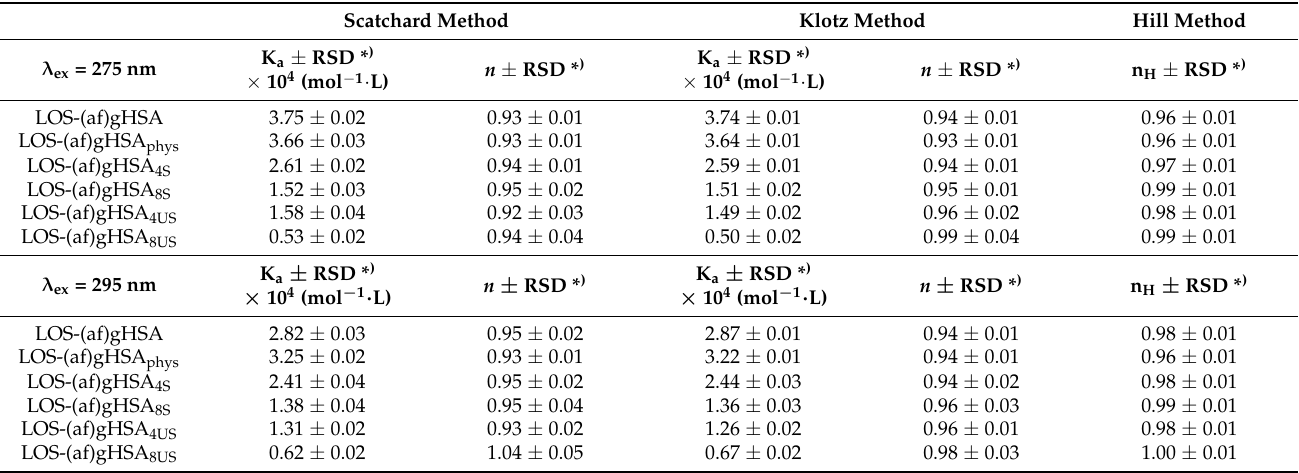
Table 3. Association constants K a (mol − 1 · L), mean number of LOS moles bound with one mole of (af)gHSA, (af)gHSA phys , (af)gHSA 4S , (af)gHSA 4US , (af)gHSA 8S , and (af)gHSA 8US ( n ), the Hill coefficient (n H ) in The LOS–albumin systems; λ ex = 275 nm, λ ex = 295 nm. Scatchard Method Klotz Method Hill